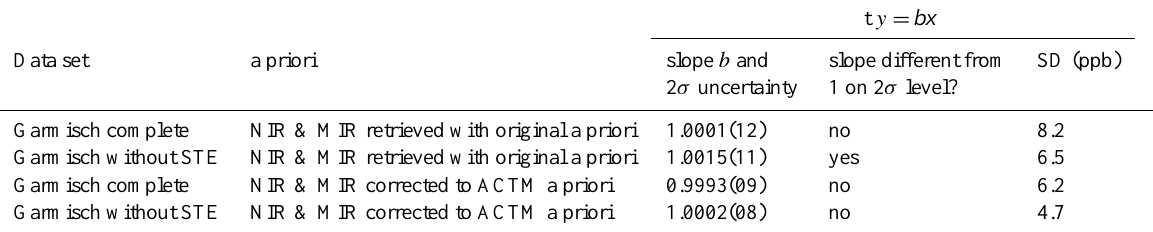
Table 4. As Table 2, but only for Garmisch using MIR and NIR retrievals which are coincident to the STE trajectory data set. Data sets are divided into monthly means using measurements from all days (Garmisch complete) or only days without STE events at Garmisch (Garmisch without